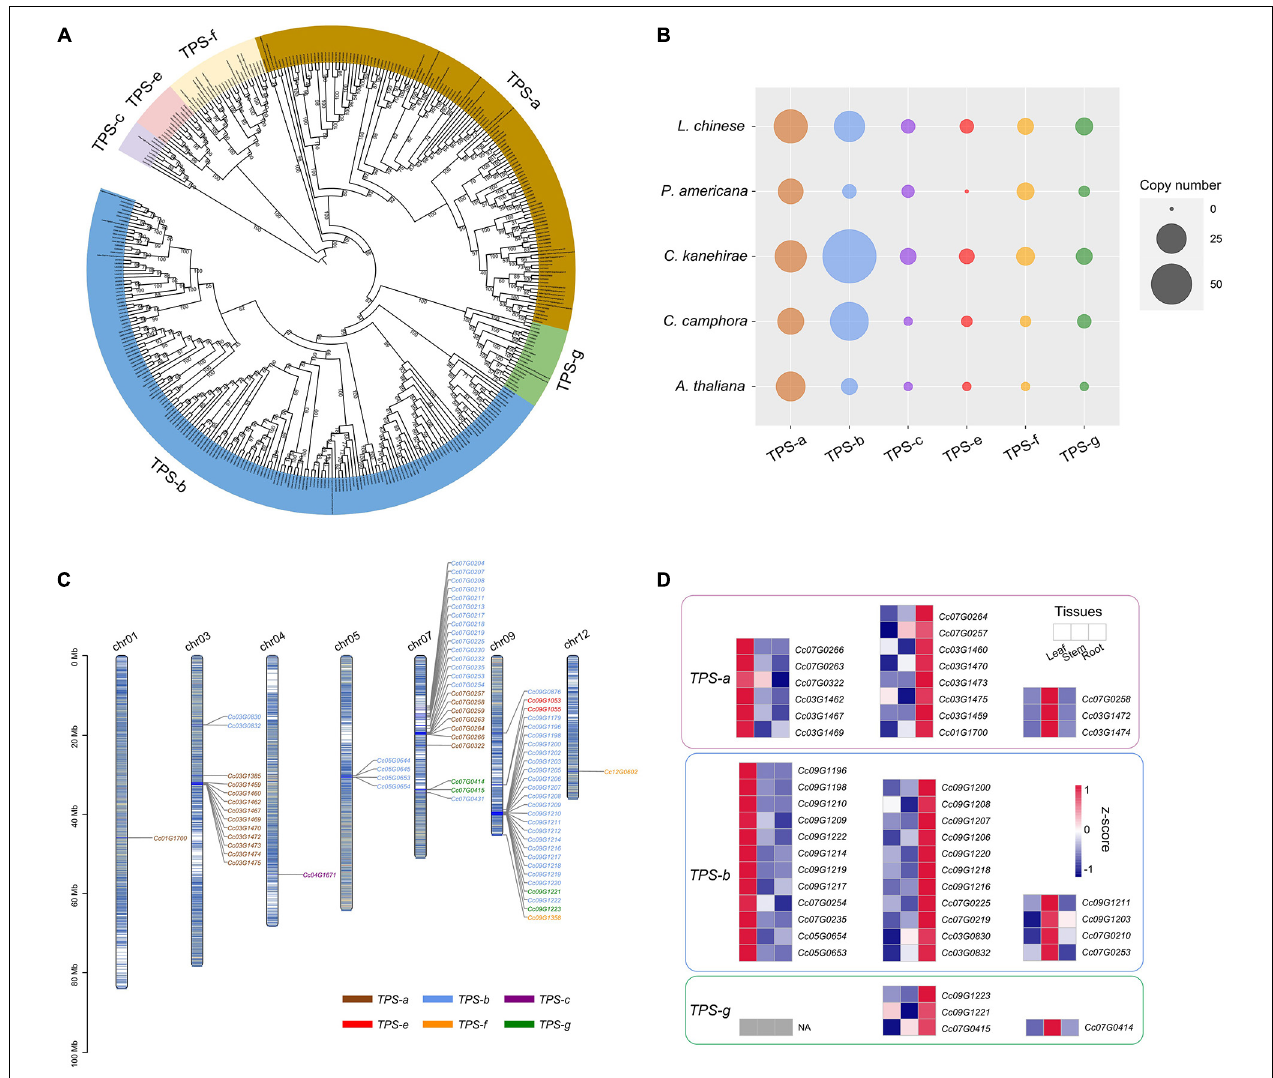
FIGURE 5 | Genes involved in the biosynthesis of volatile terpenoids. (A) Phylogenetic analyses of TPS genes in C. camphora . The phylogenetic tree was constructed based on TPS gene sequences from four magnoliid genomes ( C. camphora , C. kanehirae , P. americana and L. chinense ) and A. thaliana . (B) Copy numbers of TPS genes in the genomes of four magnoliids and A. thaliana . (C) Distribution of the TPS genes on seven chromosomes of C. camphora . (D) Tissue-specific expressions of TPS-a , TPS-b and TPS-g